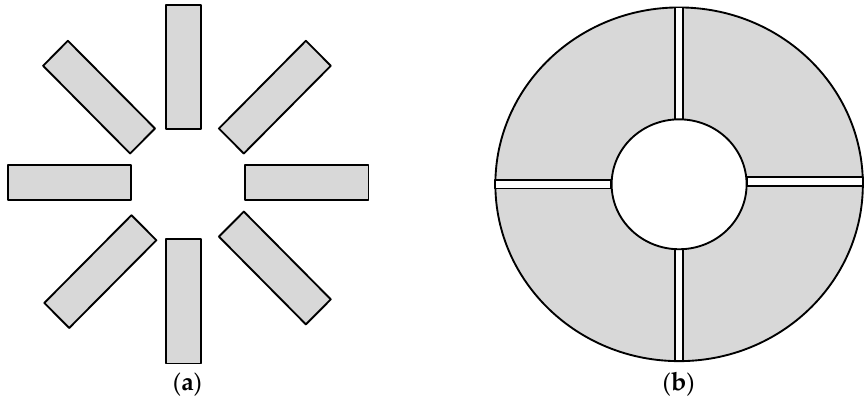
Figure 24. S pecial structures of the shield. ( a ) octagon, ( b ) sectors.